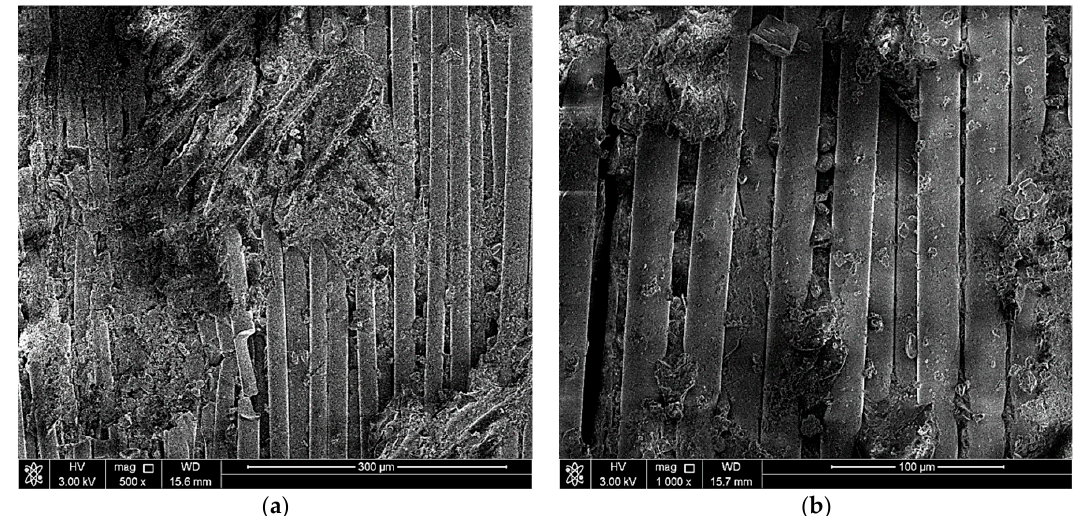
Figure 5. SEM images of the fractured region at ( a ) 500× and ( b ) 1000×.